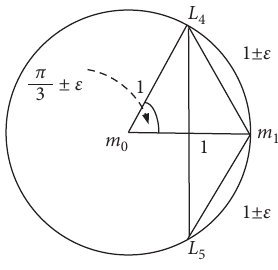
Figure 3: The position of artificial triangular